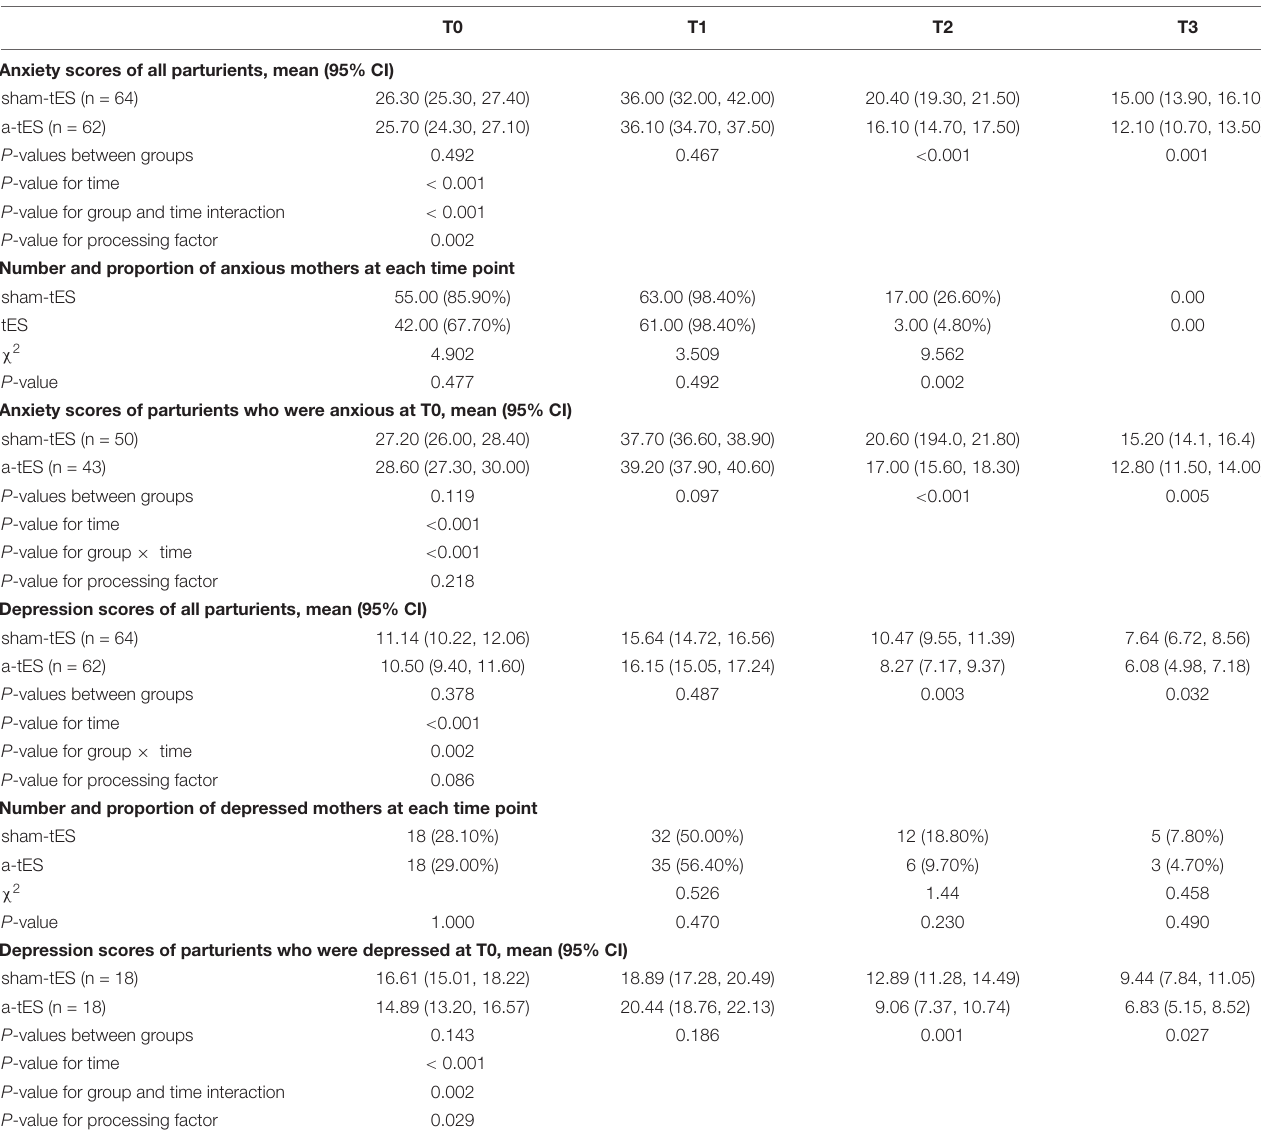
TABLE 2 | Comparison of anxiety and depression between the two groups. T0 T1 T2